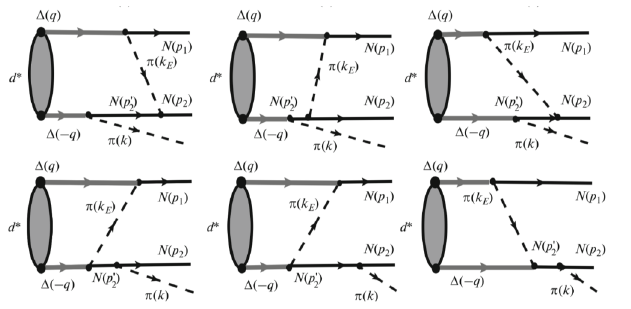
Figure 3. Illustration of d (cid:3) (2380) ! NN (cid:25)